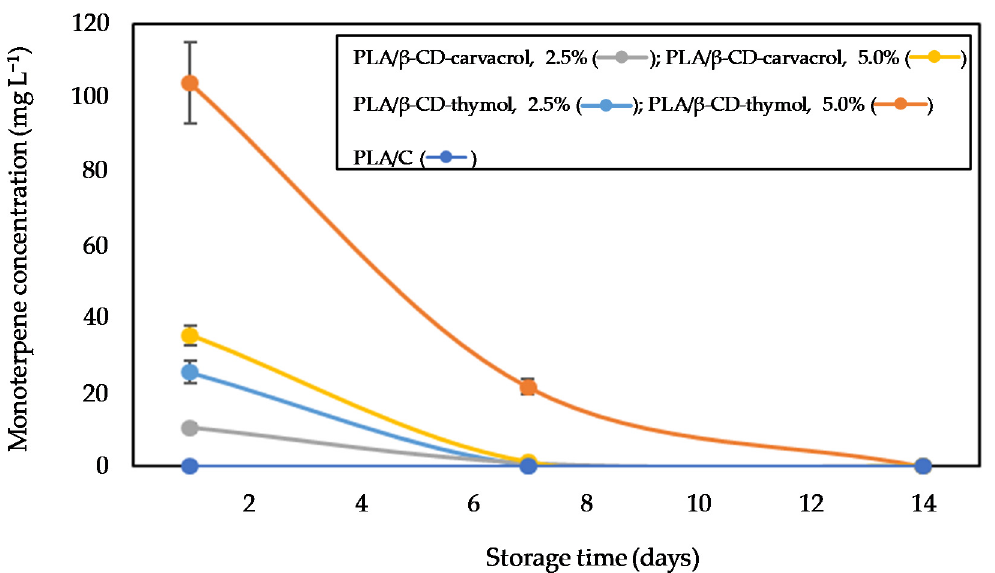
Figure 4. Carvacrol and thymol concentrations in mg L − 1 (ppm) in the headspace of PLA packages (see inset legend in the figure), by GC-MS at 0, 7, 14, 21 days of storage at 4 °C. Data points represent averages and standard deviations of three replicate samples.